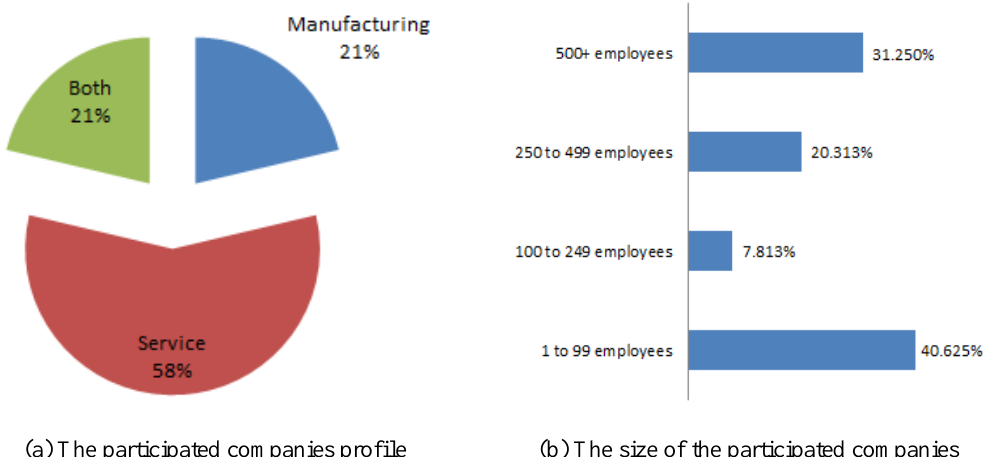
Figure 1. Surveyed companies’